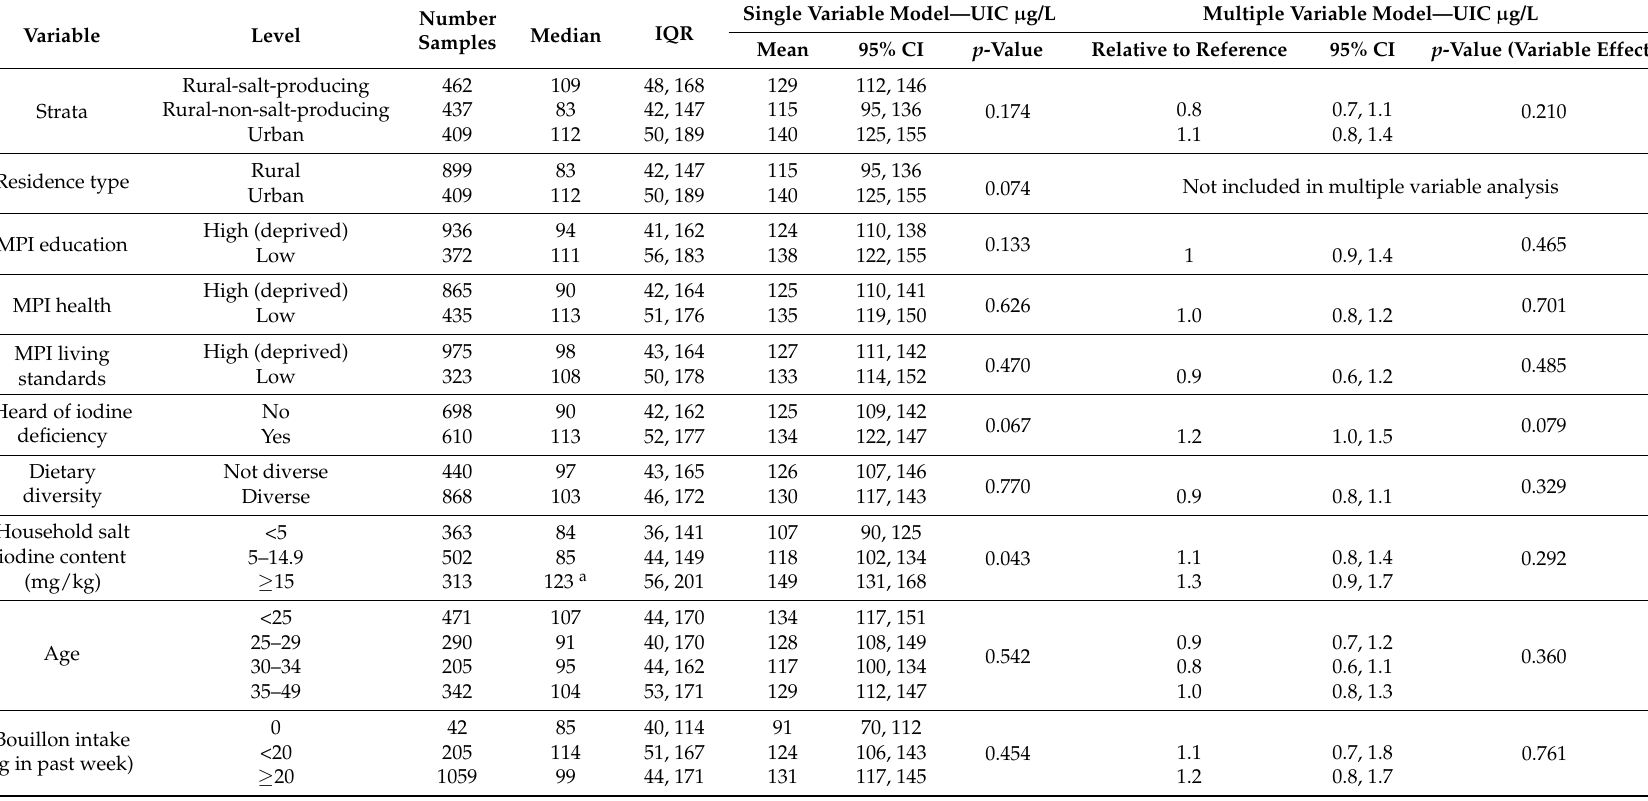
Table 4. Regression analyses of factors associated with urinary iodine concentration (UIC) µ